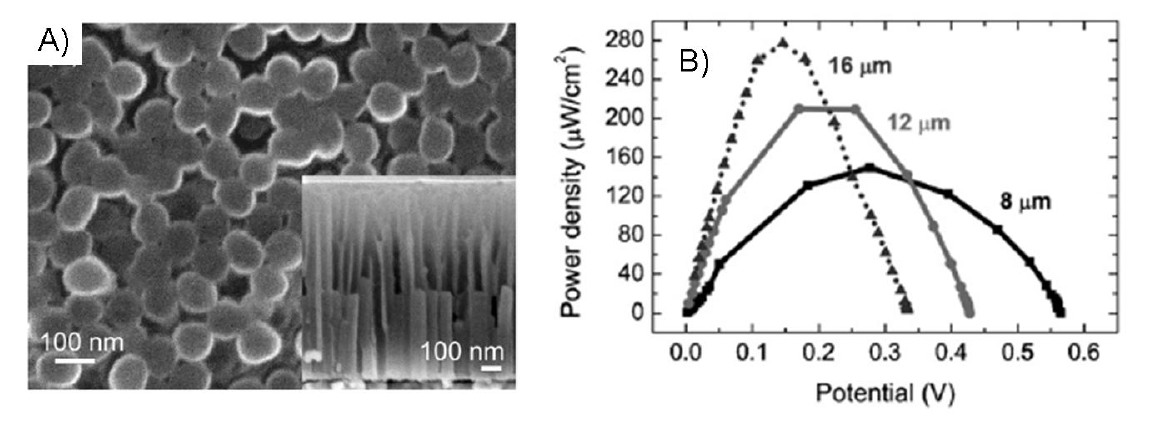
Figure 8. (A) Field emission scanning electron microscopy (FESEM) images of 80 nm diameter polypyrrole-HQS-GOx nanowires grown using anodized aluminum oxide (AAO)-Si template. The inset shows a cross-sectional view. (B) Dependence of the power density on the cell voltage for biofuel cells employing nanowires with different length. Reprinted from [74] with permission from